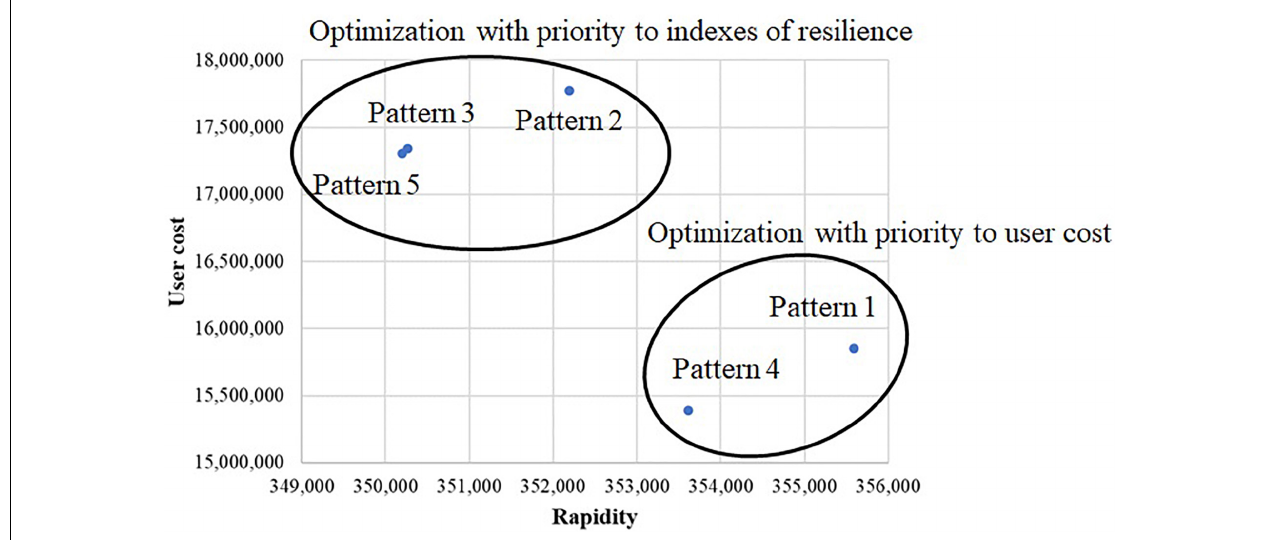
FIGURE 11 | Relationship between rapidity and user